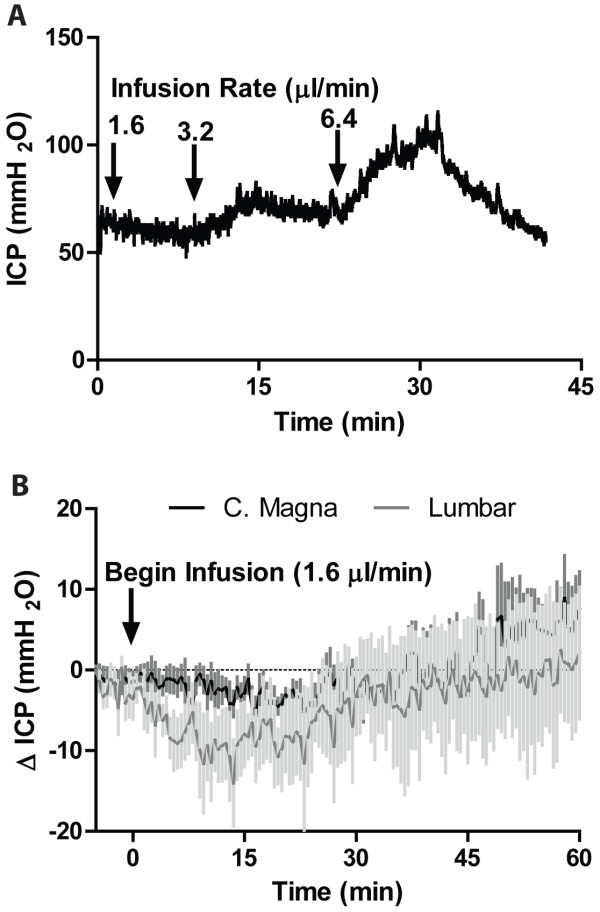
Defining the effect of intrathecal tracer infusion on intracranial pressure (ICP). Ventricular ICP was monitored continuously during infusion of CSF tracer Texas Red-conjugated dextran (TR-d3, MW 3 kD) in rats. (A) Intracisternal TR-d3 infusion at 1.6 ul/min did not appreciatively alter ICP, whereas increasing the infusion rate to 3.2 and 6.4 ul/min significantly elevated ICP. (B) Intracisternal and lumbar infusion of TR-d3 did at 1.6 μl/min for 60min did not significantly alter ICP (n = 4 per group).